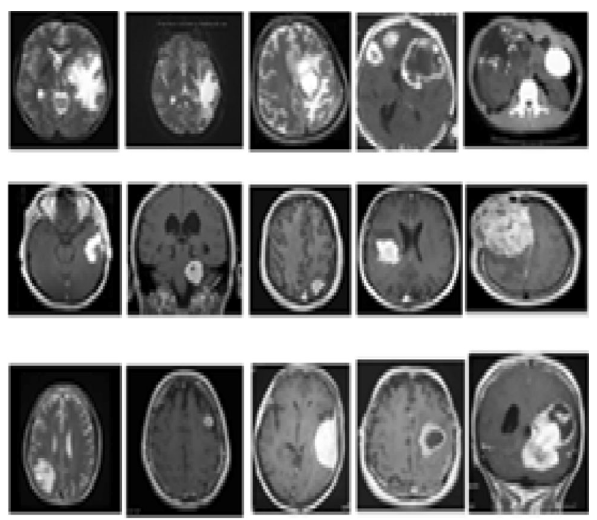
Fig. 2 Brain tumor image